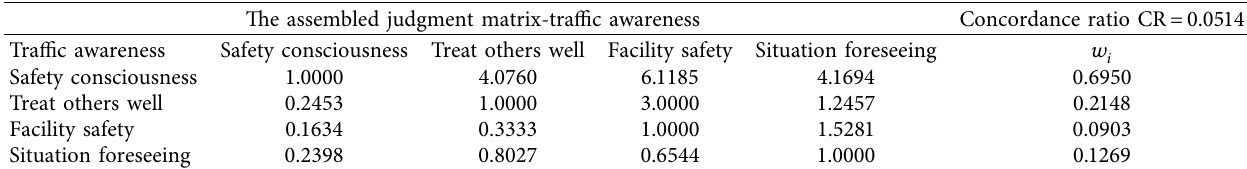
Table 4: Discrimination matrix of traffic awareness level indicators and weight.